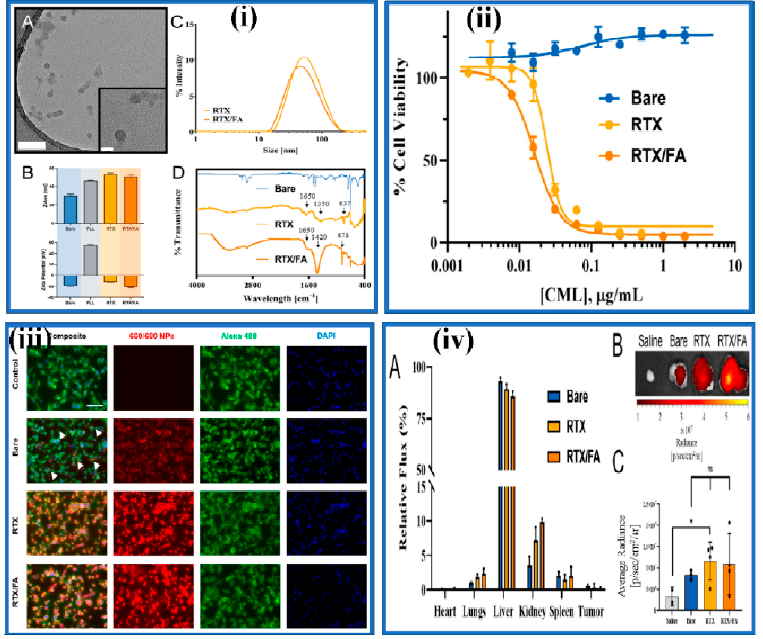
Figure 5. Illustration depicts the formulation design, in vitro , and in vivo evaluation of folate-modified raltitrexed-loaded multifunctional nanoparticles (RTX/FA NP) as cancer theranostics. ( i ) Physical characterization of raltitrexed (RTX) and RTX/FA NP formulations; [A] TEM images,